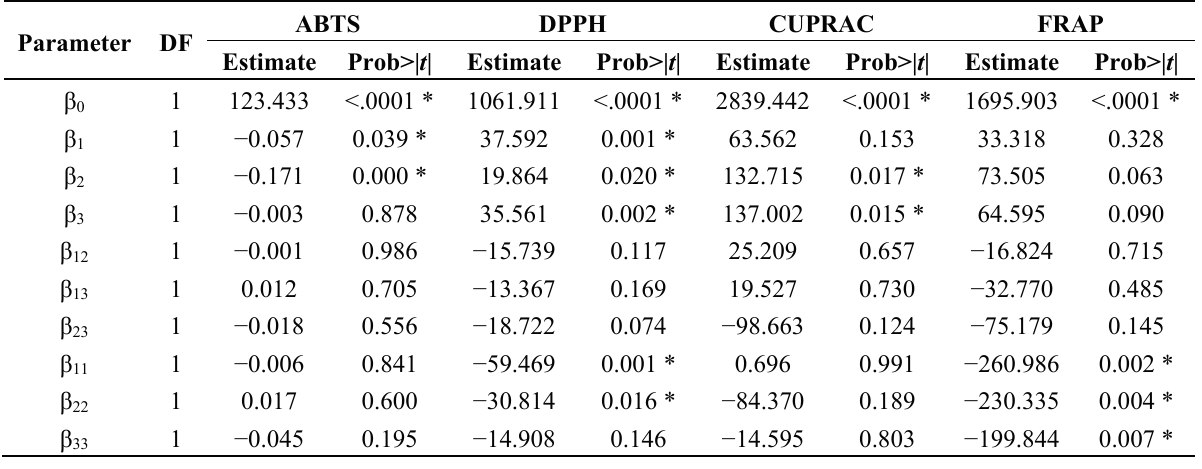
Table 4. Analysis of variance for the experimental results on antioxidant capacity.